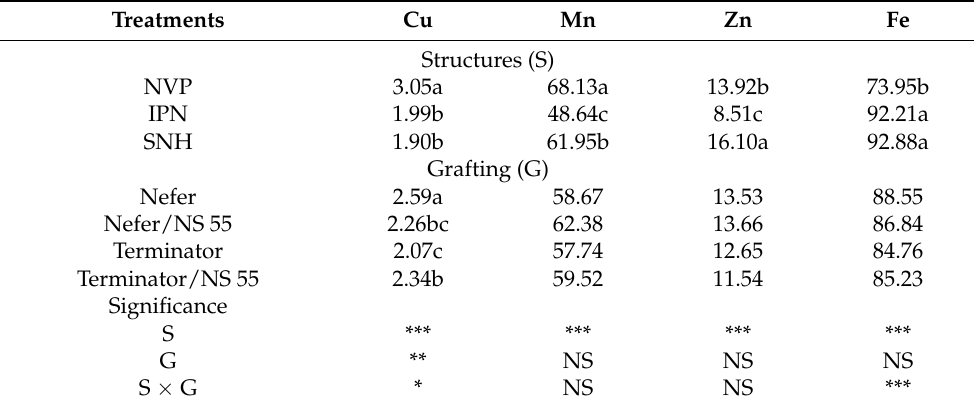
Table 8. Effect of structures and graft combinations on accumulation microelements in leaves (mg kg − 1 dry weight;